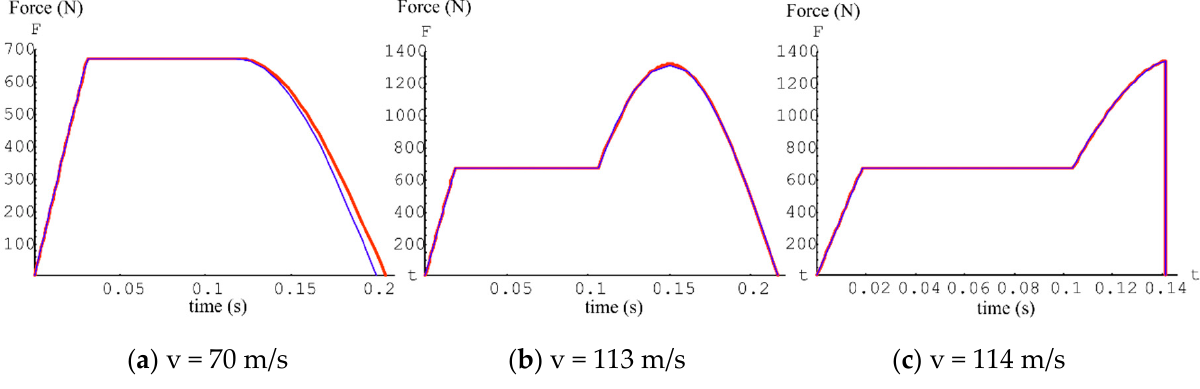
( c ) v = 114 m/s Figure 12. Elongations at various initial velocities (v = 70 m/s, 113 m/s, 114 m/s). Number of seg- ments = 1000, red line: approximate solution, blue line: exact solution. 5. Conclusions The applicability and benefits of a tailored tether for an airborne wind energy system (AWES) were investigated. The AWES system with a tether structure was simplified as a two-degree-of-freedom system and an exact response was mathematicallyobtained. The composite tether was proven to show better endurance under impulsive loading com- pared to the conventional structure since more mechanical work was required to reach complete structure failure, thanks to the multiple load paths (primary and secondary ele- ments). Furthermore, an approximate response model was developed, which resulted in